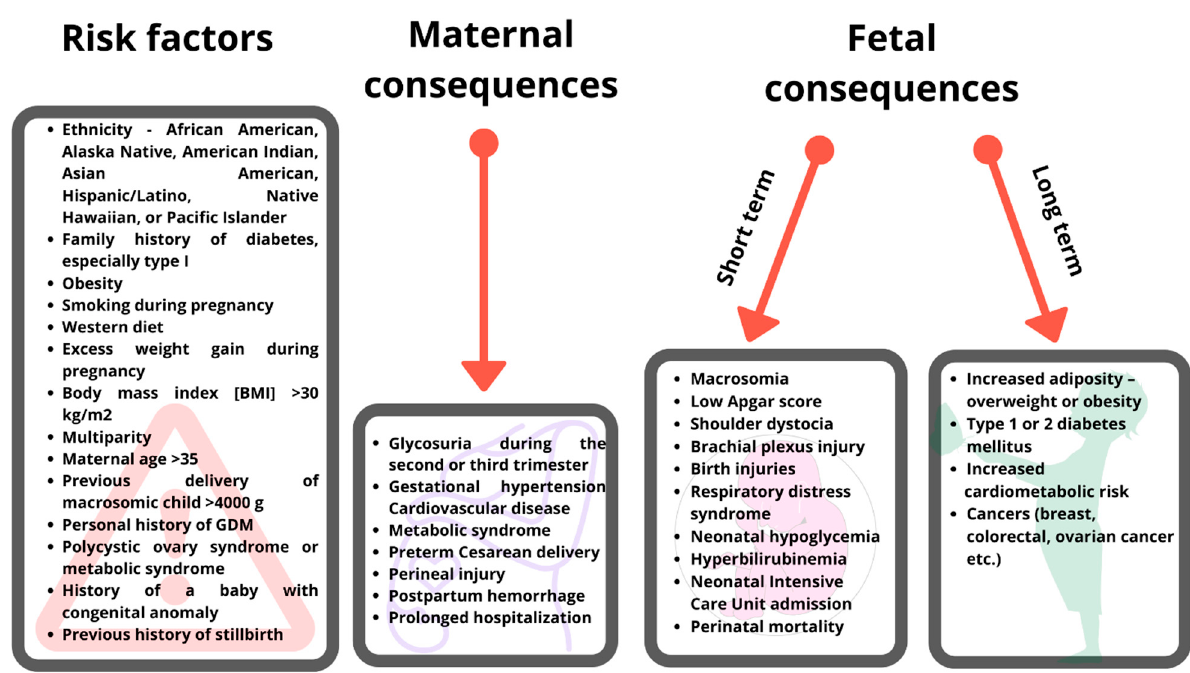
Figure 1. Consequences of gestational diabetes mellitus (GDM) on the mother, fetus, and offspring.